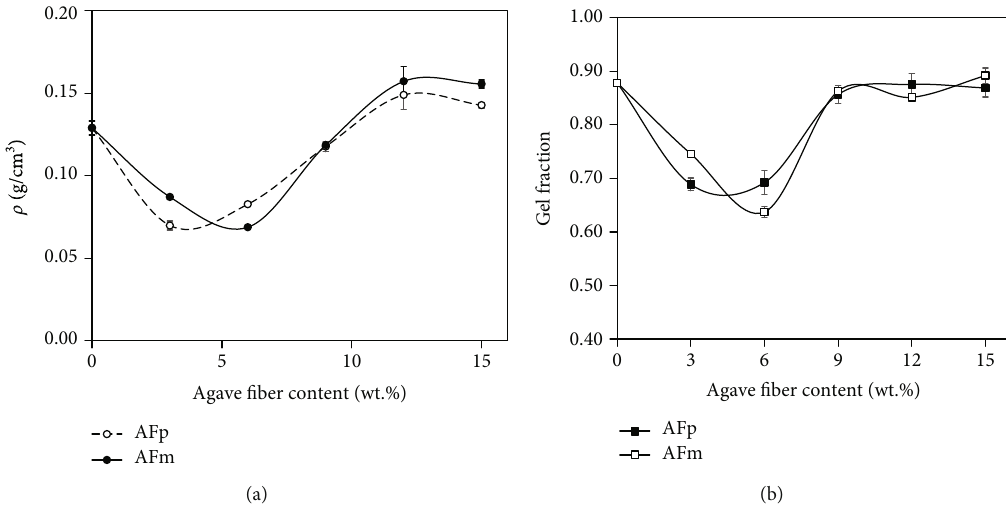
Figure 2: Apparent density ( ρ ) and GF of composite foams containing AF